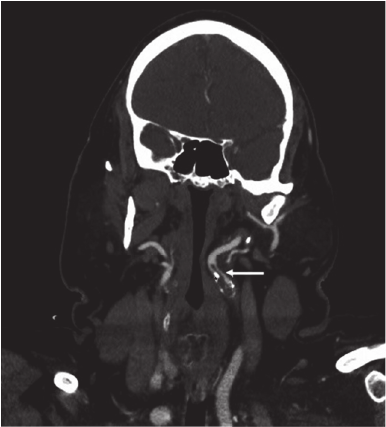
Figure 3: Sagittal oblique reformatted view from CT angiogram again depicts the intraluminal thrombus within the left internal carotid artery (white